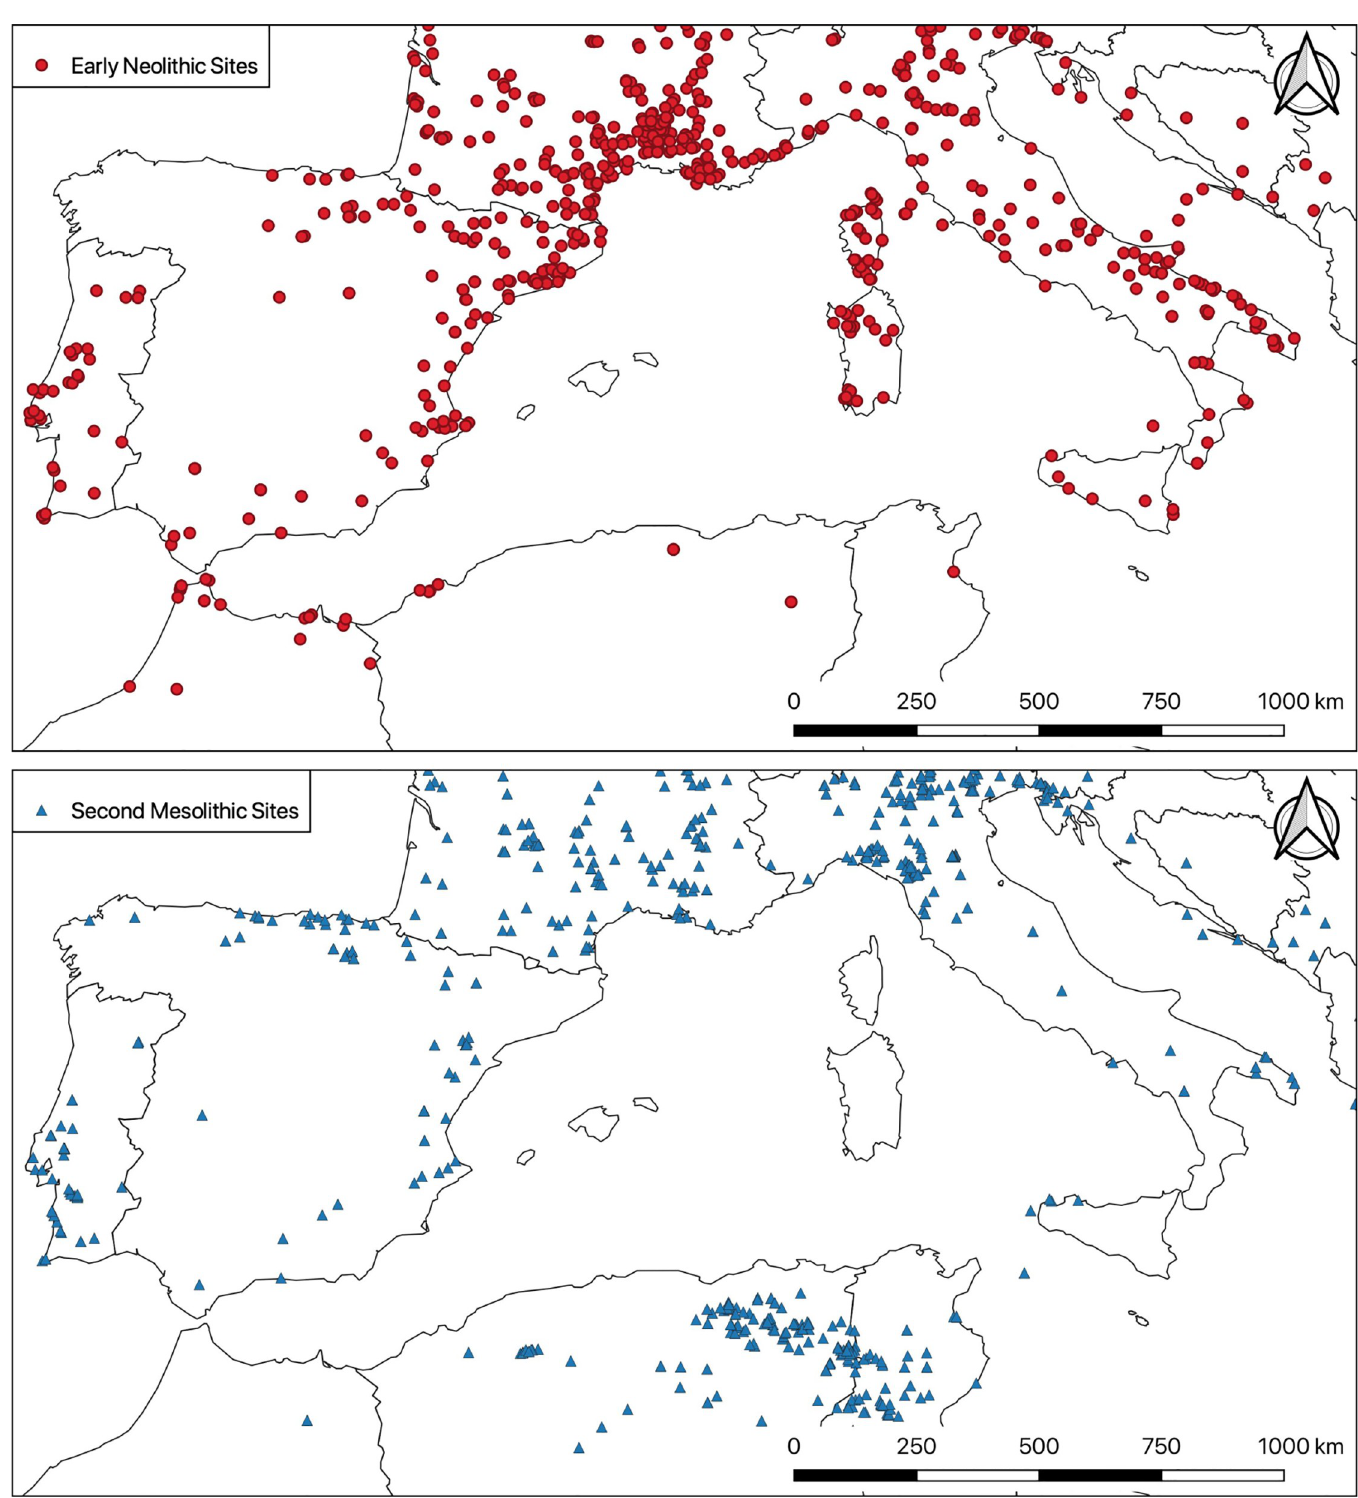
Fig 1. Main second Mesolithic and early Neolithic sites. Distribution maps of the main second Mesolithic (after ~ 6,500 BCE) and early Neolithic sites in the Western Mediterranean (according to the BDA database https://bda.huma-num.fr/ [56]). Countries boundaries are from Natural Earth (free vector and raster map data @